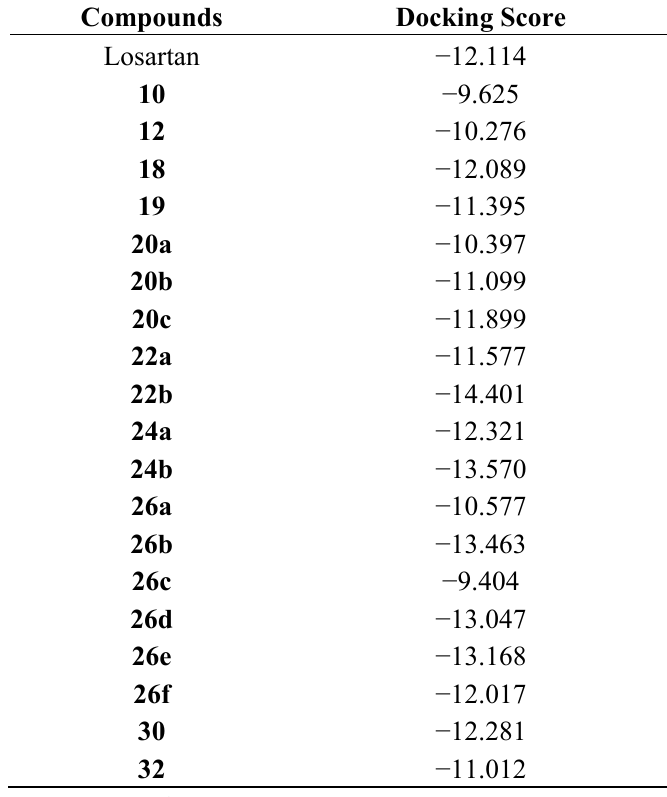
Table 1. Highest Docking Scores of the synthesized analogues obtained with GLIDE/IFD a